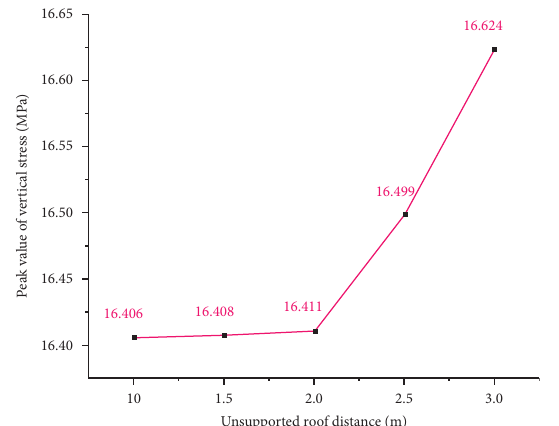
Figure 13: The influence of the change in the unsupported roof distance on the vertical stress peak value of the upper part.